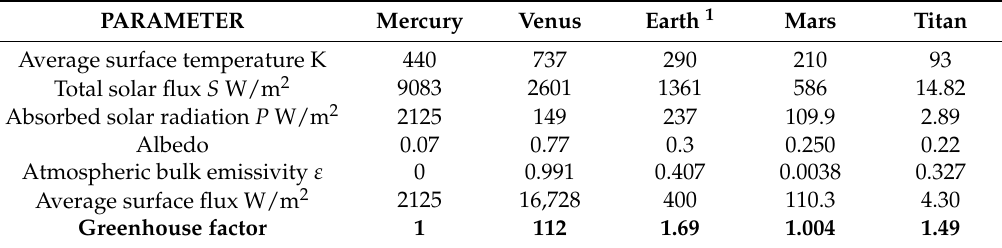
Table 2. Calculated greenhouse factors for rocky planets and